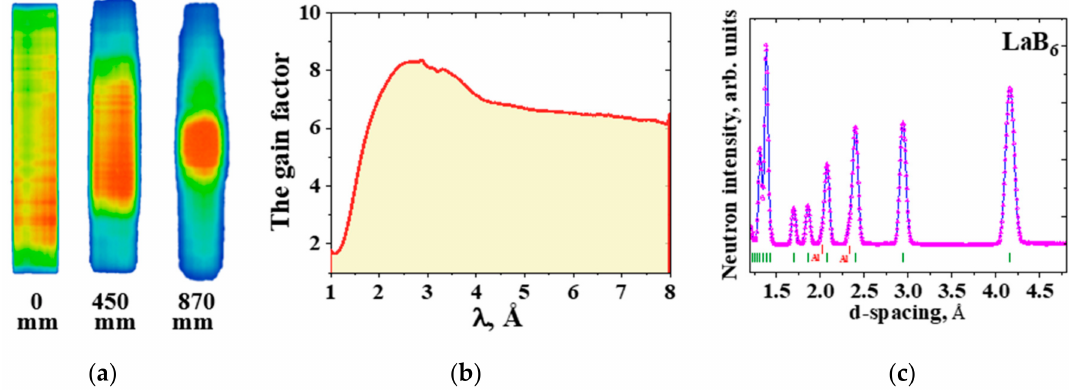
Figure 2. ( a ) The profiles of the neutron beam of 6b beamline obtained at different distances from the neutron focusing section output. The coloring scheme shows neutron intensity distribution from low (blue) to high (red). ( b ) The spectral distribution of the gain factor of the incident neutron beam flux after the focusing section related to one of the old straight section of the neutron guide. ( c ) The neutron diffraction pattern of LaB 6 processed by the Rietveld method. The experimental points and calculated profiles are shown. Ticks below represent calculated positions of the nuclear peaks of the cubic phase of LaB 6 at ambient conditions. The shoulder peaks from aluminum container are marked.